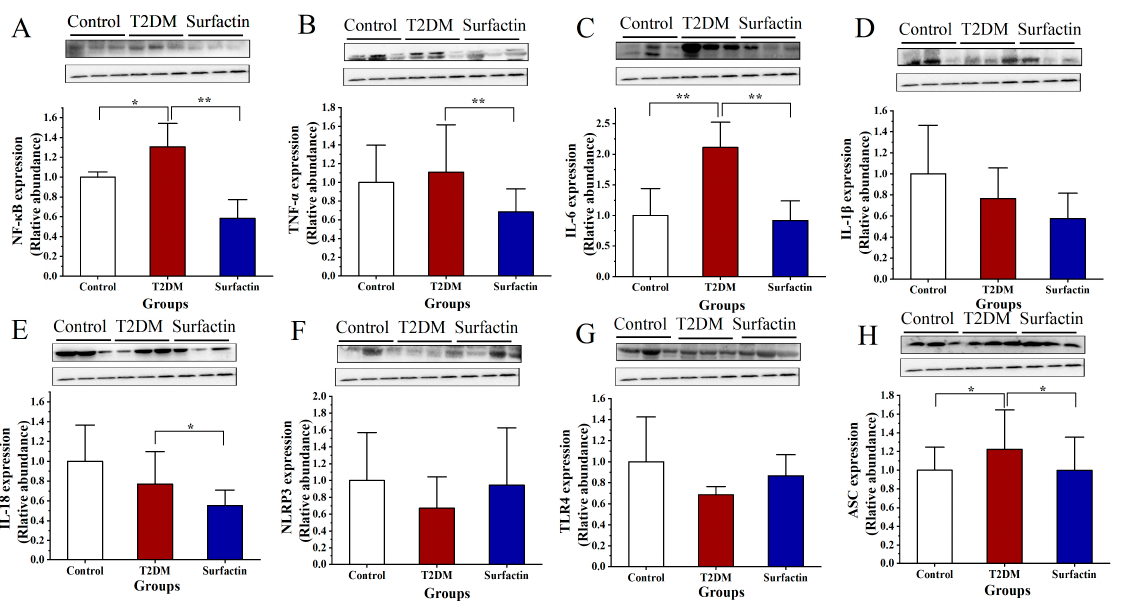
Figure 5. Effect of surfactin on colon inflammation in HFD/STZ-induced T2DM mice. The control group represents normal mice fed a basic diet, the T2DM group represents mice with T2DM induced by a 60% fat diet and 30 mg/kg body weight STZ, and the surfactin group represents T2DM mice treated with 80 mg/kg body weight surfactin. The levels of NF- κ B ( A ), TNF- α ( B ), IL-6 ( C ), IL-1 β ( D ), IL-18 ( E ), NLRP3 ( F ), TLR4 ( G ) and ASC ( H ). * indicates significant differences at p < 0.05, ** indicates significant differences at p < 0.01.